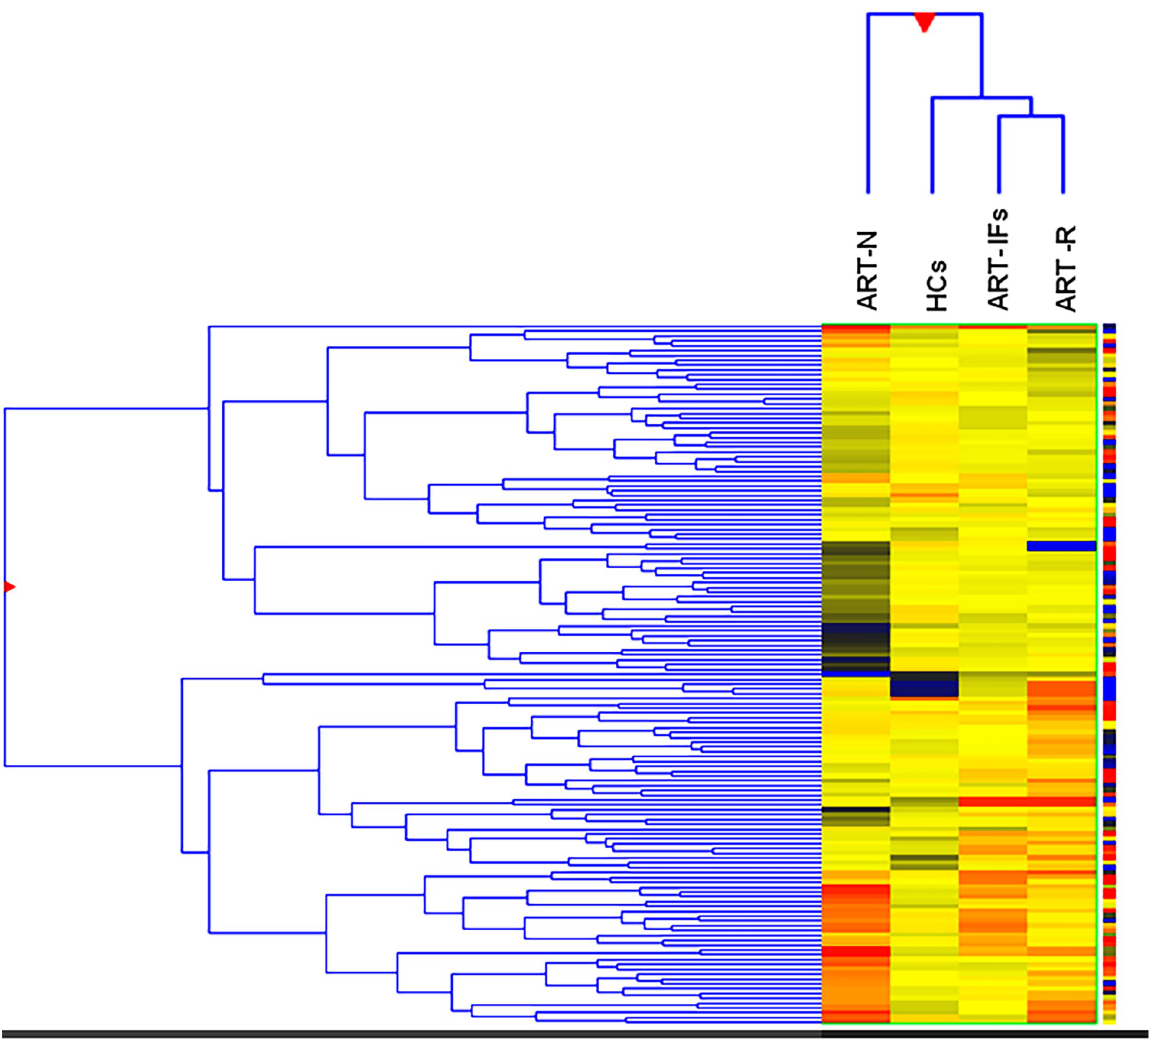
Fig 2. Heatmap and hierarchical clustering of genes in studied groups. Hierarchical clustering (Hcl) expression image is shown. It is also clear from the above Hcl expression image i.e. ART-IF and ART-R clustered together. Red color shows over-expressed genes ( > 2.0) & Blue color shows under-expressed genes ( < 2.0). (The Hcl expression plot has been generated based on log2 normalized intensity value).